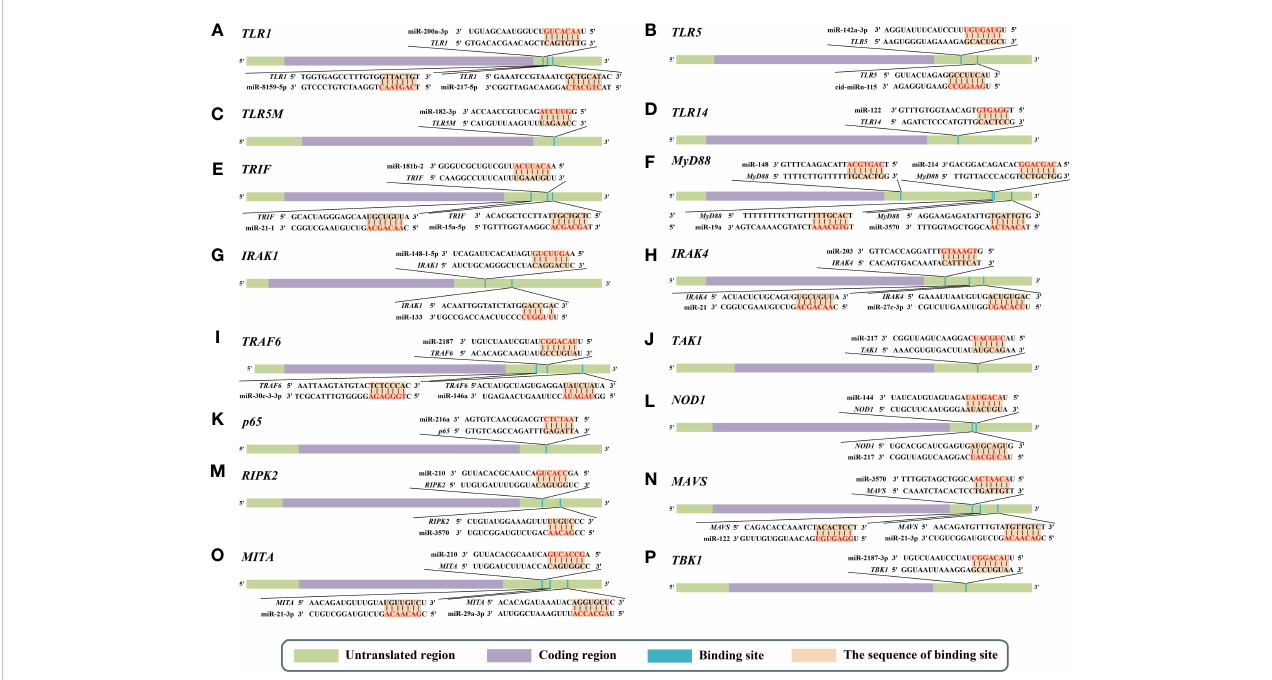
FIGURE 2 Predicted microRNA (miRNA) binding sites in the 3 ’ untranslated regions (UTRs) of different genes of nuclear factor-kappa B (NF- k B) pathways in aquatic animals. (A) Predicted binding sites in the 3 ’ UTR of TLR1 . (B) Predicted binding sites in the 3 ’ UTR of TLR5 . (C) Predicted binding sites in the 3 ’ UTR of TLR5M (the membrane form of TLR5). (D) Predicted binding sites in the 3 ’ UTR of TLR14 . (E) Predicted binding sites in the 3 ’ UTR of TRIF . (F) Predicted binding sites in the 3 ’ UTR of MyD88 . (G) Predicted binding sites in the 3 ’ UTR of IRAK1 . (H) Predicted binding sites in the 3 ’ UTR of IRAK4 . (I) Predicted binding sites in the 3 ’ UTR of TRAF6 . (J) Predicted binding sites in the 3 ’ UTR of TAK1 . (K) Predicted binding sites in the 3 ’ UTR of p65 . (L) Predicted binding sites in the 3 ’ UTR of NOD1 . (M) Predicted binding sites in the 3 ’ UTR of RIPK2 . (N) Predicted binding sites in the 3 ’ UTR of MAVS . (O) Predicted binding sites in the 3 ’ UTR of MITA . (P) Predicted binding sites in the 3 ’ UTR of TBK1 . The red markings represent seed